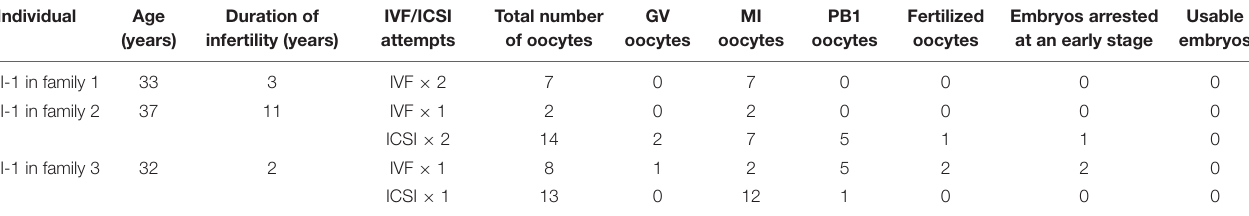
TABLE 1 | Oocyte and embryo characteristics of the IVF/ICSI attempts of the three probands. Individual Age Duration of (years) infertility (years)